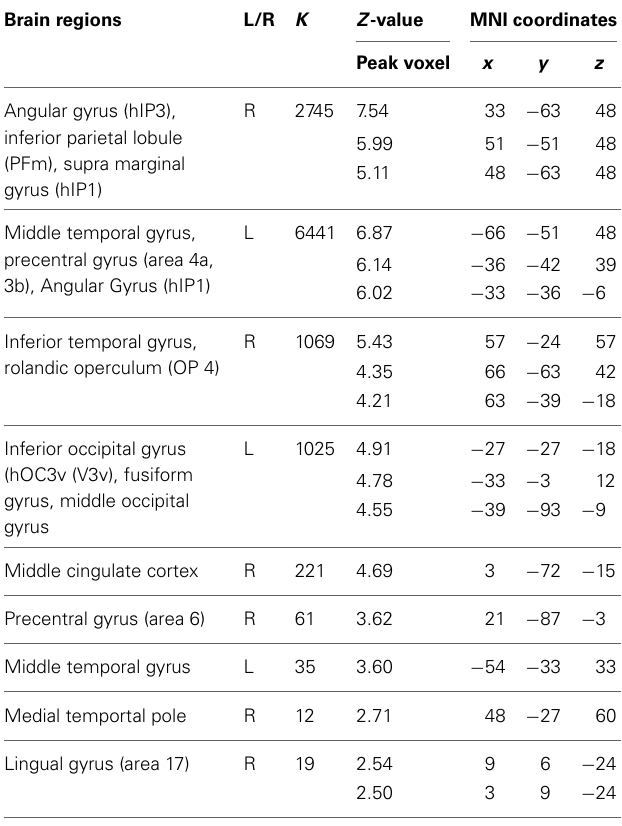
Table 5 | Neural activations for the contrast AU 2 + > OC2 +